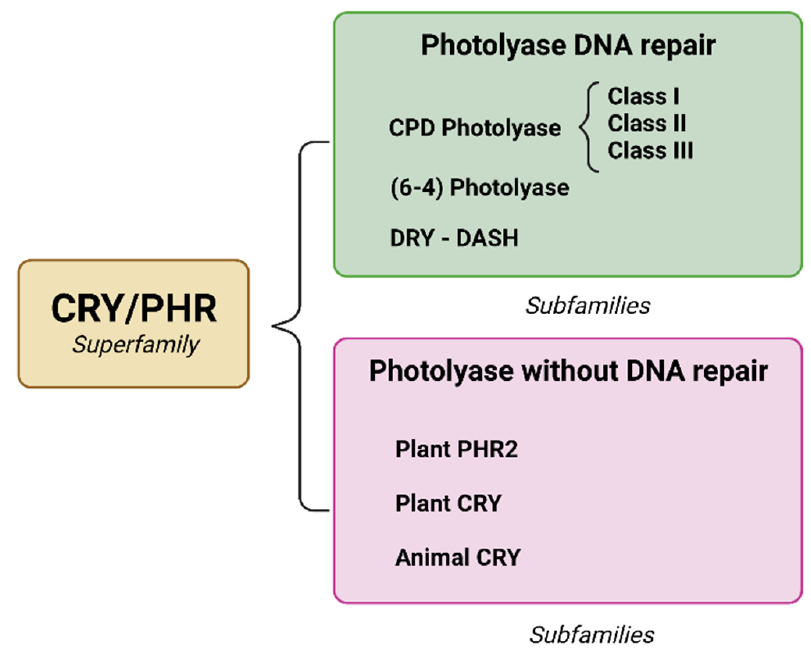
Figure 3. Integration of the CRY/PHR superfamily and the emergence of subfamilies due to evolu- tionary changes. The main distinctions are the ability to repair specific DNA and loss of photorepair capacity. Created with BioRender.com.